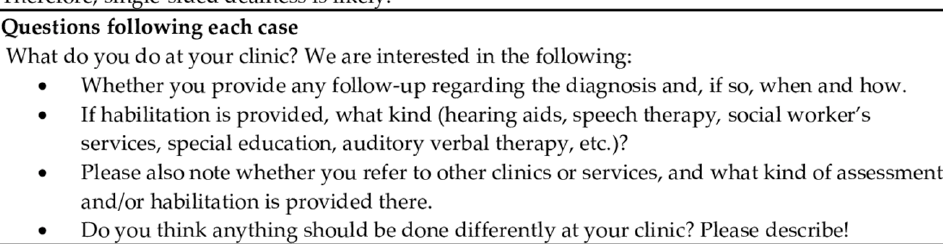
Figure 1. Questions and case vignettes presented in the survey.